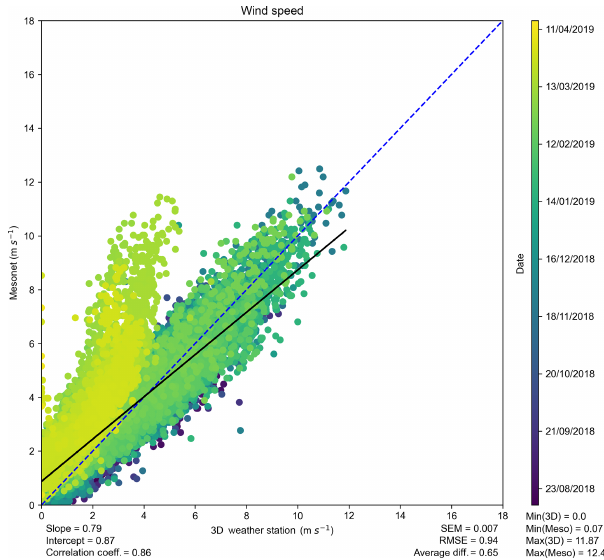
Figure 9. Comparison of the 3D-printed anemometer using a Hall effect sensor ( x ) and the Oklahoma Mesonet ( y ) for the entire de- ployment, color-coded by time. The one-to-one reference line (blue dashed) and linear regression line (black solid) are overlaid.